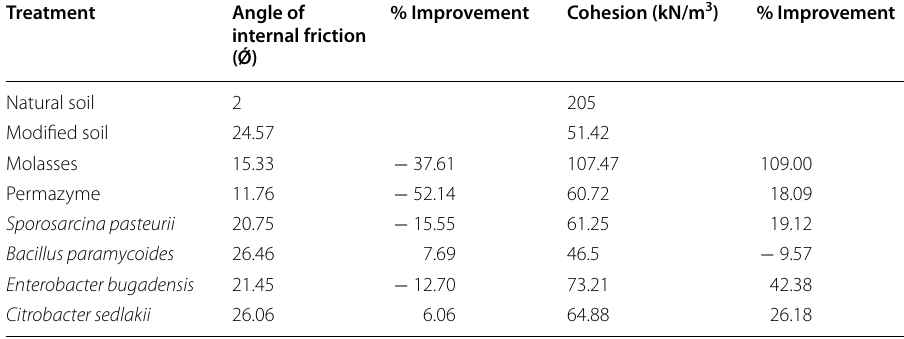
Table 9 Unconsolidated-undrained triaxial compression test results Treatment Angle of % Improvement Cohesion (kN/m 3 ) % Improvement internal friction (Ǿ) Natural soil 2 205 Modified soil 24.57 Molasses Permazyme Sporosarcina pasteurii Bacillus paramycoides Citrobacter